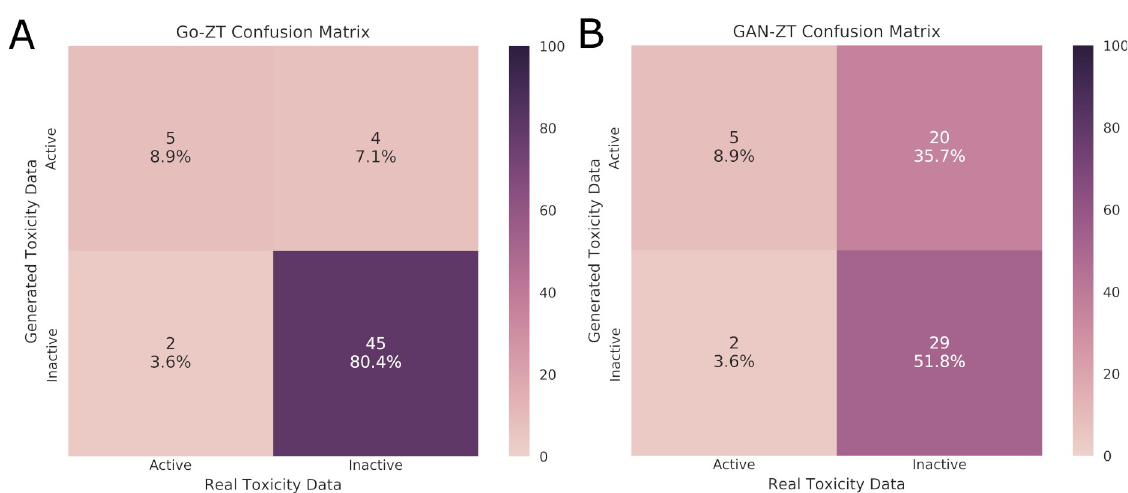
Fig 7. Test dataset confusion matrices. Evaluation of the classification of chemicals in the test data set as either active or inactive using real versus generated toxicity matrices by (A) Go-ZT or (B) GAN-ZT. Color scale represents percent of total chemicals.